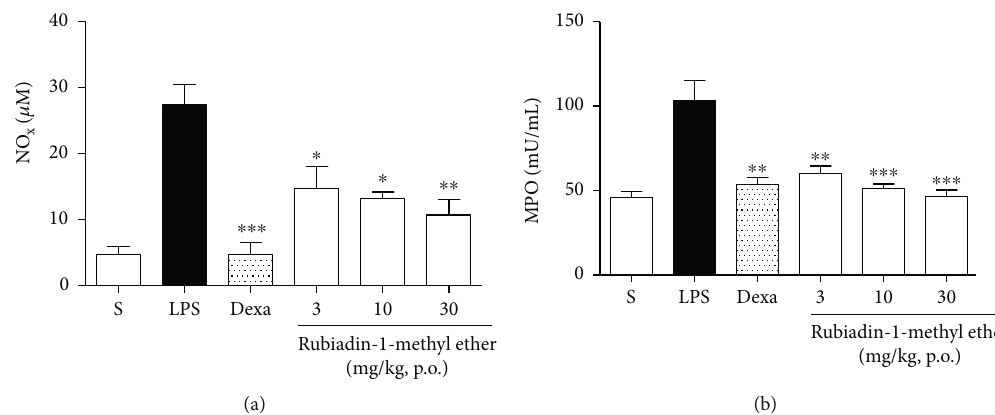
Figure 6: Measurement of NO levels and MPO activity. E ff ect of Rubiadin-1-methyl ether on measurement of NO levels (a) and MPO activity (b). S: healthy animals only treated with 0.9% sterile saline and vehicle (1% DMSO); LPS: (negative control) in fl amed animals only stimulated with LPS (1 μ g/mL) at intranasal route (i.n.).; Dexa: (positive control) animals pretreated with Dexamethasone (5 mg/kg, p.o.) 1h before LPS administration; Rubiadin-1-methyl ether: animals pretreated with Rubiadin-1-methyl ether at doses at 3, 10, and 30 mg/kg (p.o.) 1 h before LPS administration. The results were expressed as the mean ± S : D : ; n = 6 ; ∗ P < 0 : 05 , ∗∗ P < 0 : 01 , and ∗∗∗ P < 0 : 001 compared with the LPS group. Table 1: E ff ects of Rubiadin-1-methyl ether on pro- and anti-in fl ammatory cytokine levels in LPS-induced acute lung injury (ALI) in mice.